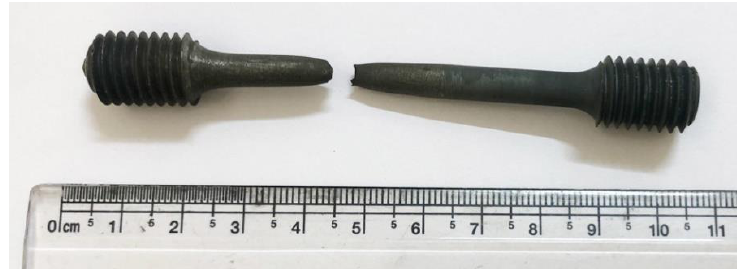
Figure 9. The tensile failure location of PWHT joint tested at 700 °C.